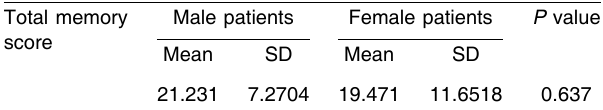
Table 3 Comparison of the mean of total memory scores between male and female patients Total memory Male patients Female patients score